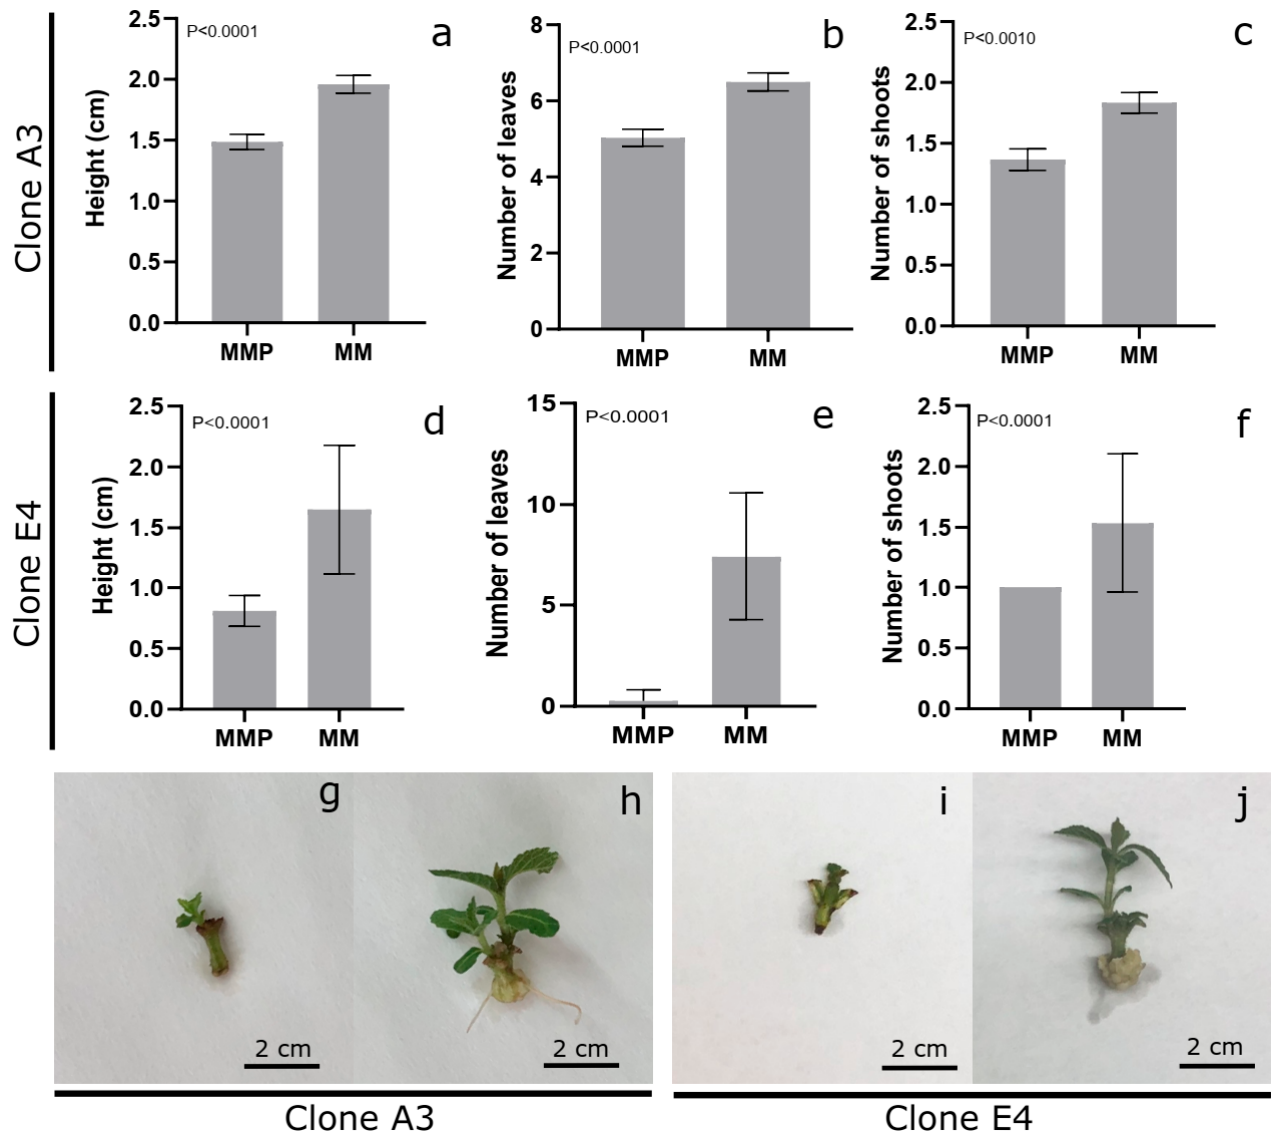
Figure 1. Growth of teak A3 and E4 shoots in PT medium in the presence (MMP) and absence (MM) of isothiazolinones biocide (Polibac). The growth parameters (plant height, number of leaves, and number of shoots) were evaluated 30 days after inoculation. Figures ( a – c ) show the height, number of leaves, and number of shoots of clone A3, respectively. Figures ( d – f ) show the height, number of leaves, and number of shoots of clone E4, respectively. Figures ( g , h ) show the phenotype of shoots cultivated in the presence or absence of isothiazolinones in clone A3, respectively. Figures ( i , j ) show the phenotype of shoots cultivated in the presence or absence of isothiazolinones in clone E4, respectively. For all the parameters analyzed, 30 clones ( n = 30) were used.